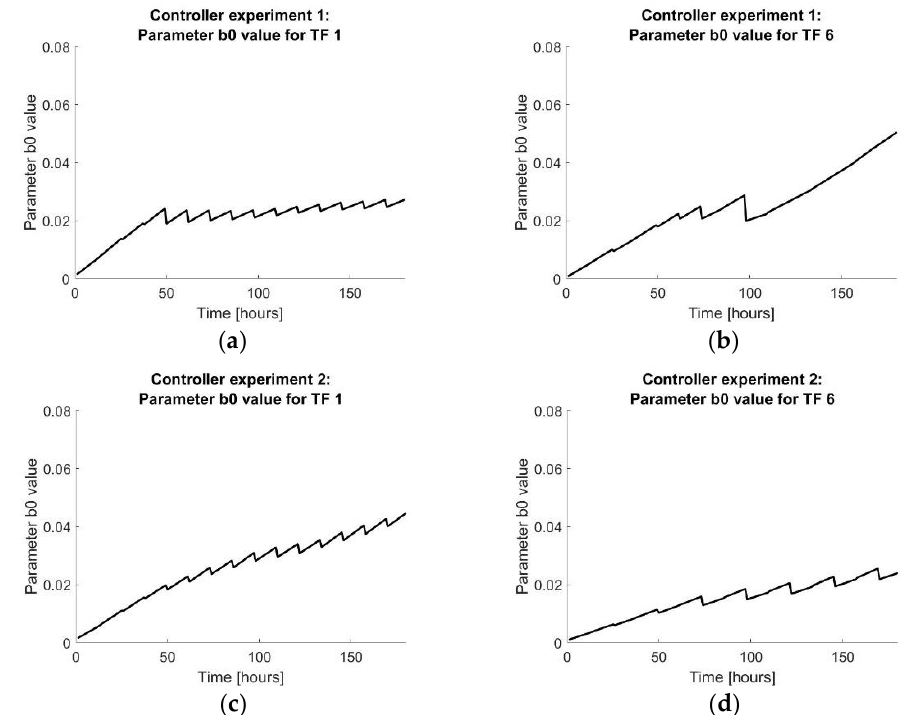
Figure 12. (a) The 𝑏 0 value over time of the resulting DARX model for tissue flasks 1 of controller experiment 1. (b) The 𝑏 0 value over time of the resulting DARX model for tissue flasks 6 of controller experiment 1. (c) The 𝑏 0 value over time of the resulting DARX model for tissue flasks 1 of controller experiment 2. (d) The 𝑏 0 value over time of the resulting DARX model for tissue flasks 6 of controller experiment 2.